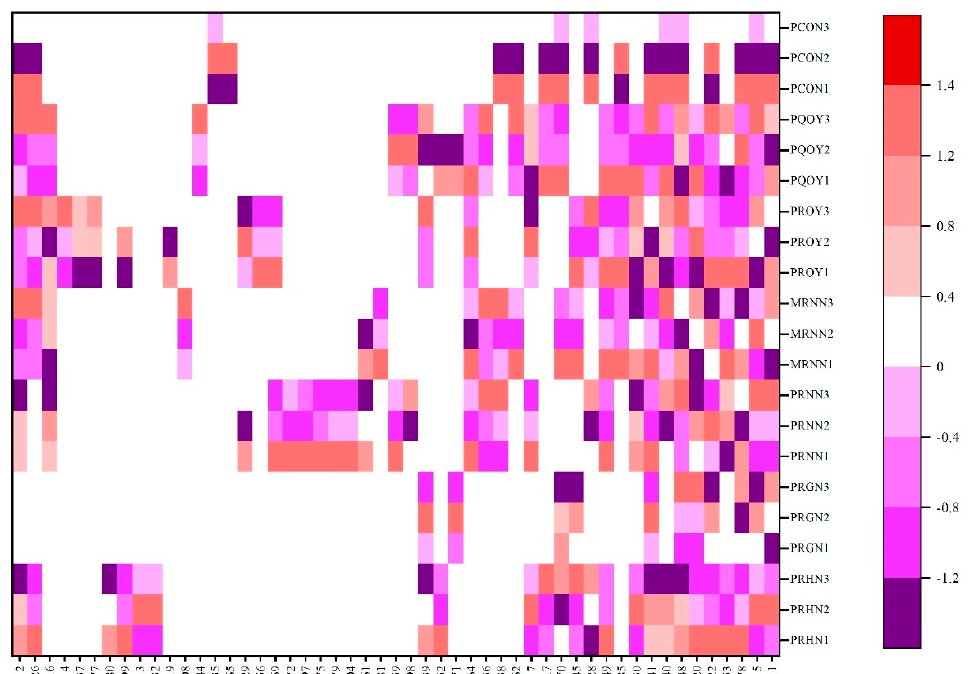
absent in PRHN, PRGN, and PRNN (half-net room, little-net room, and big-net room cul- tivation modes) and present in PROY, PQOY, and PCON (open-air cultivation modes). Figure 3. S plot of VOC-based OPLS-DA model analysis among Citrus sinensis ‘hongjiang’.